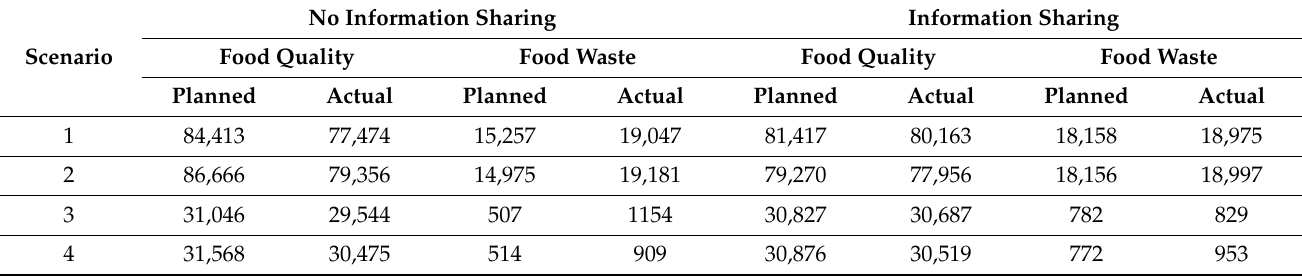
Table 4. Model output of planned and actual values obtained of the model (numbers represent day average of the simulated period).